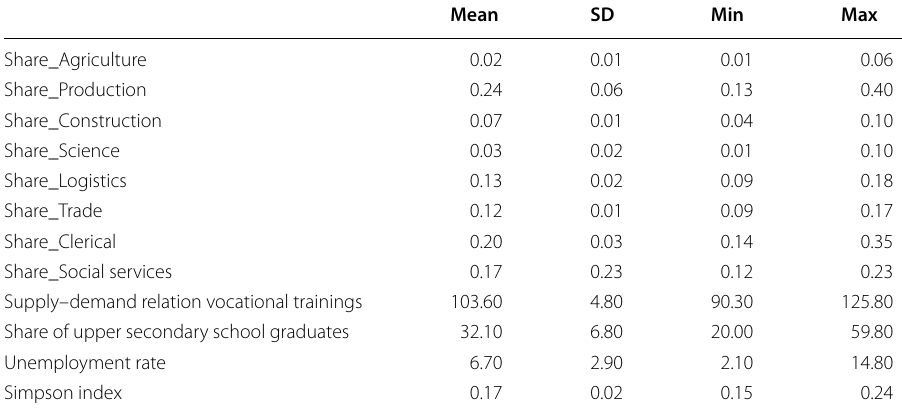
Table 11 Descriptive statistics of the regional